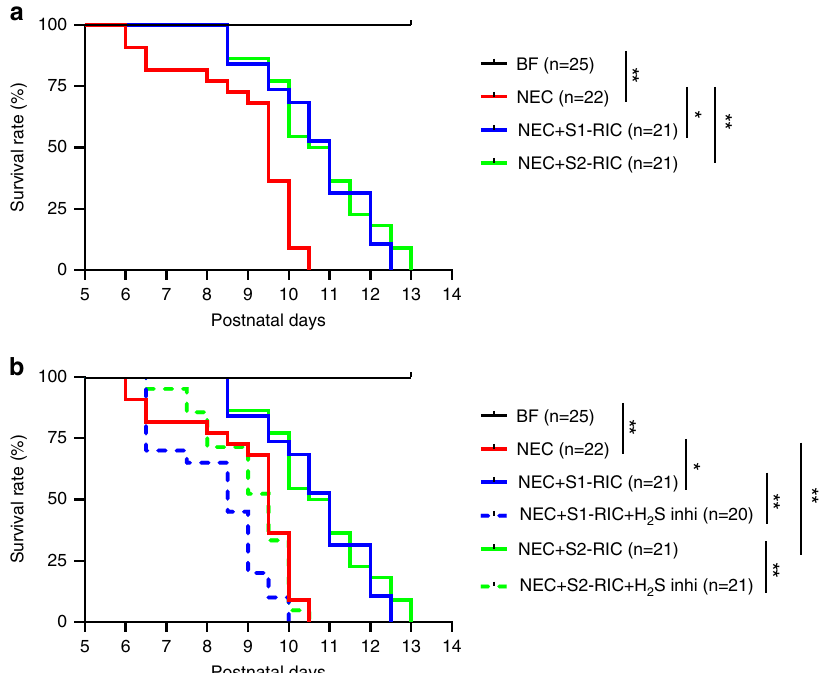
Fig. 8 RIC enhanced survival during and after NEC and this effect was abolished following administration of H 2 S-synthesizing enzyme inhibitors. a After P9, pups from all groups except breastfed (BF) controls, continued to receive gavage feeding three times per day by single investigator blinded to treatment allocation and were monitored until death occurred. Pups receiving Stage 1 or 2 RIC survived signi fi cantly longer after NEC induction (* p < 0.05; ** p < 0.01). b Survival rate after P9 was similar between NEC pups and NEC pups receiving Stage 1 or 2 RIC and given H 2 S-synthesizing enzyme inhibitors (* p < 0.05; ** p < 0.01). Survival curves were compared using the logrank test (* p < 0.05; ** p < 0.01). Data are presented as mean ± SEM. Source data are provided as a Source Data fi